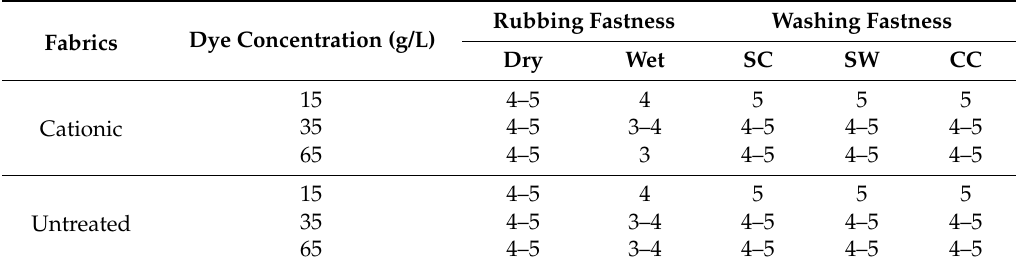
Table 2. The rubbing and washing fastness of dyed fabrics a